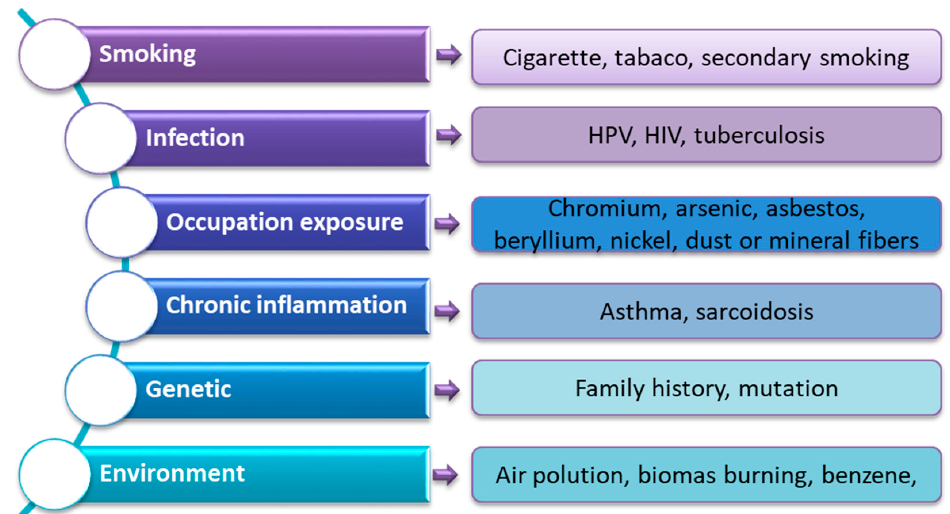
Figure 1. Risk factors for lung cancer (based on [4–11]).